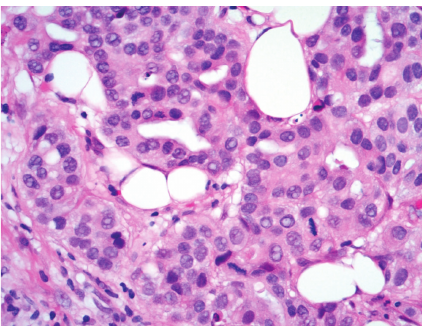
Figure 3: Photomicrograph of glandular epithelial rest in post- neoadjuvant ipsilateral axillary sentinel lymph node capsule (PAX8 immunohistochemical study, original magnification 1000x).